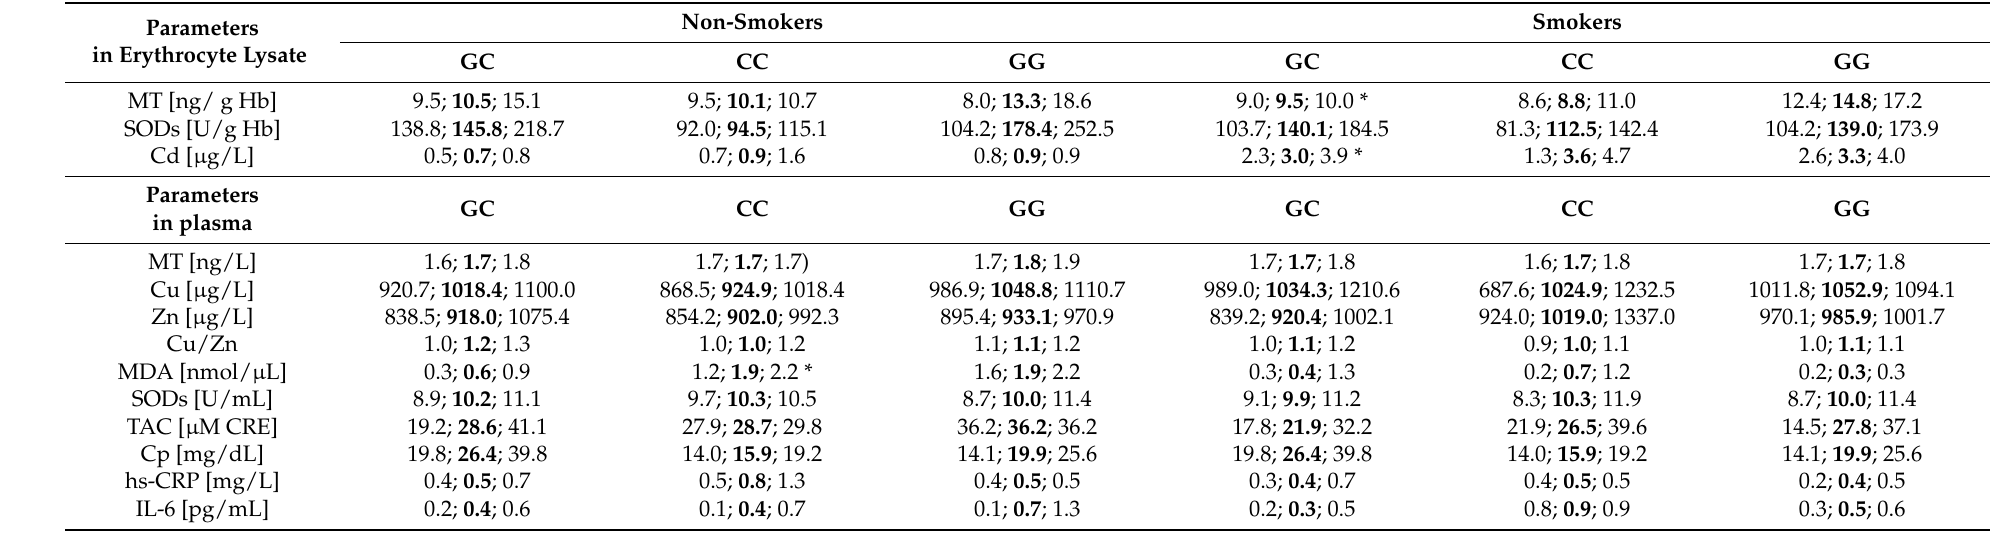
Table 7. The concentration of metals (Cu, Zn and Cd), MT, Cp and markers of inflammation and oxidative stress in the group of non-smoking and smoking healthy subjects, with regard to genotypes for rs10636 in the MT2A gene. The bold is to distinguish the median values.